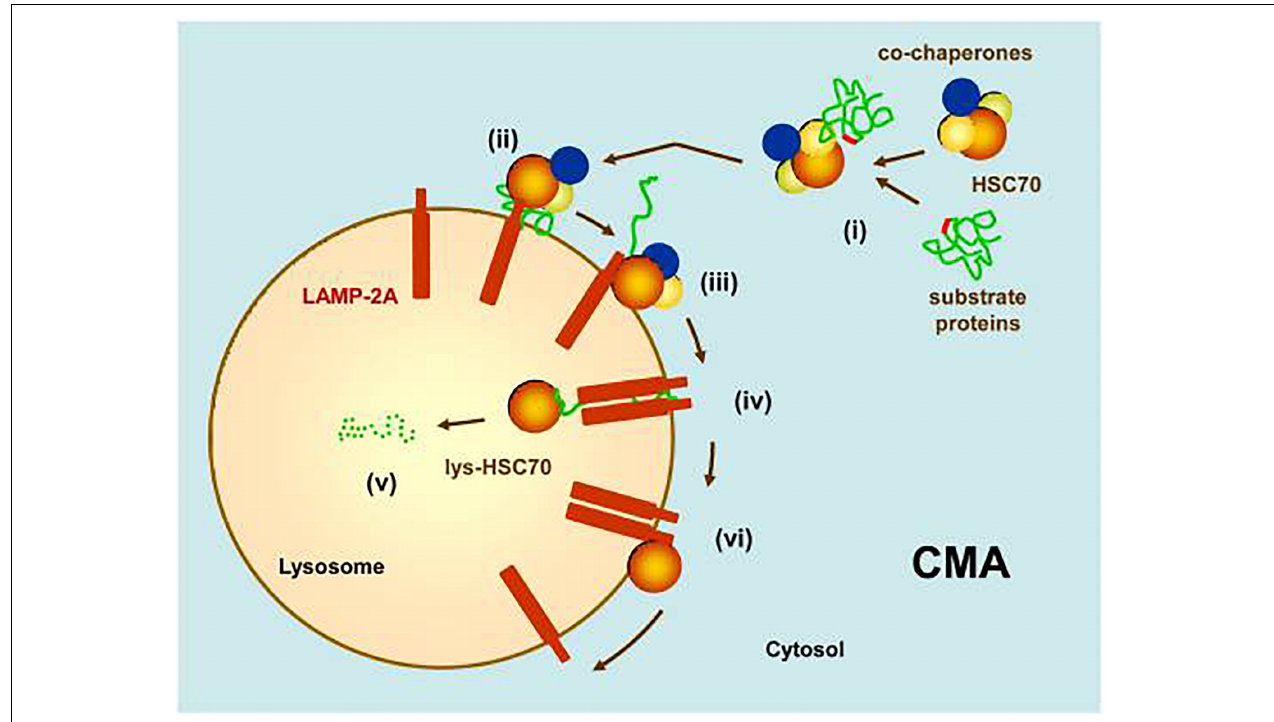
FIGURE 2 | Chaperone-mediated autophagy (CMA). (i) Substrate proteins with an amino acid sequence biochemically similar to KFERQ are recognized by HSPA8/hsc70 in association with co-chaperones. (ii) This complex binds to the monomeric form of a lysosomal surface receptor, lamp2a, which will facilitate its translocation into the lumen of the lysosome. (iii) Binding of the substrate to lamp2a causes lamp2a to multimerize into a translocation complex. (iv) After unfolding, the substrate translocates into the lysosomal lumen. The presence of a lysosomal luminal form of HSPA8/hsc70 is required for this translocation to occur. (v) The substrate is quickly degraded by lysosomal hydrolytic enzymes. (vi) Lamp2a disassembles from its translocation complex, facilitated by HSPA8/hsc70 (Reprinted from Cuervo, 2010).